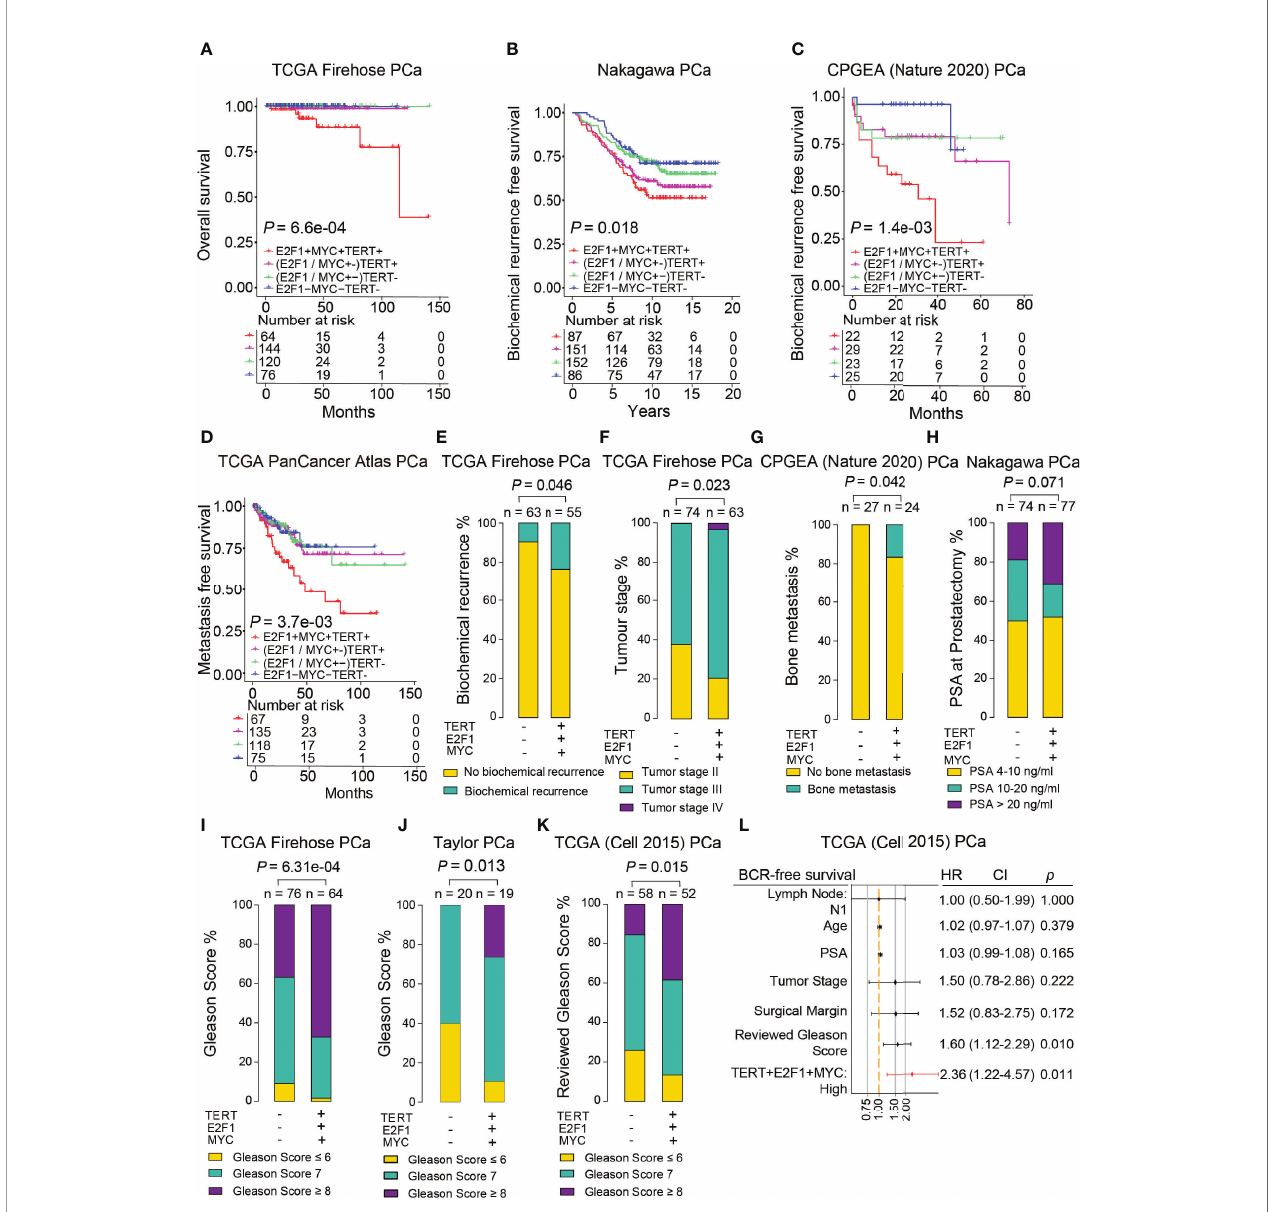
FIGURE 6 | Synergistic co-overexpression of TERT , E2F1 , and MYC correlated with escalated tumor malignancy. (A – D) Synergistic triple high expression of TERT , E2F1 , and MYC was associated with poorer overall survival (A) , higher risks for biochemical relapse (B, C) , and poorer metastatic-free survival (D) in PCa patients. (E – K) Proportion of PCa patients with biochemical relapse (E) , advanced tumor stage (F) , bone metastasis (G) , higher PSA levels (H) , and higher Gleason Score (I – K) was signi fi cantly higher in the group with triple high (+) expression of TERT , E2F1 , and MYC . (L) Multivariate Cox regression analysis examined the synergistic effect of co-overexpression of TERT , E2F1 , and MYC together with other clinicopathological features on the risk of BCR-free survival in PCa patients in TCGA